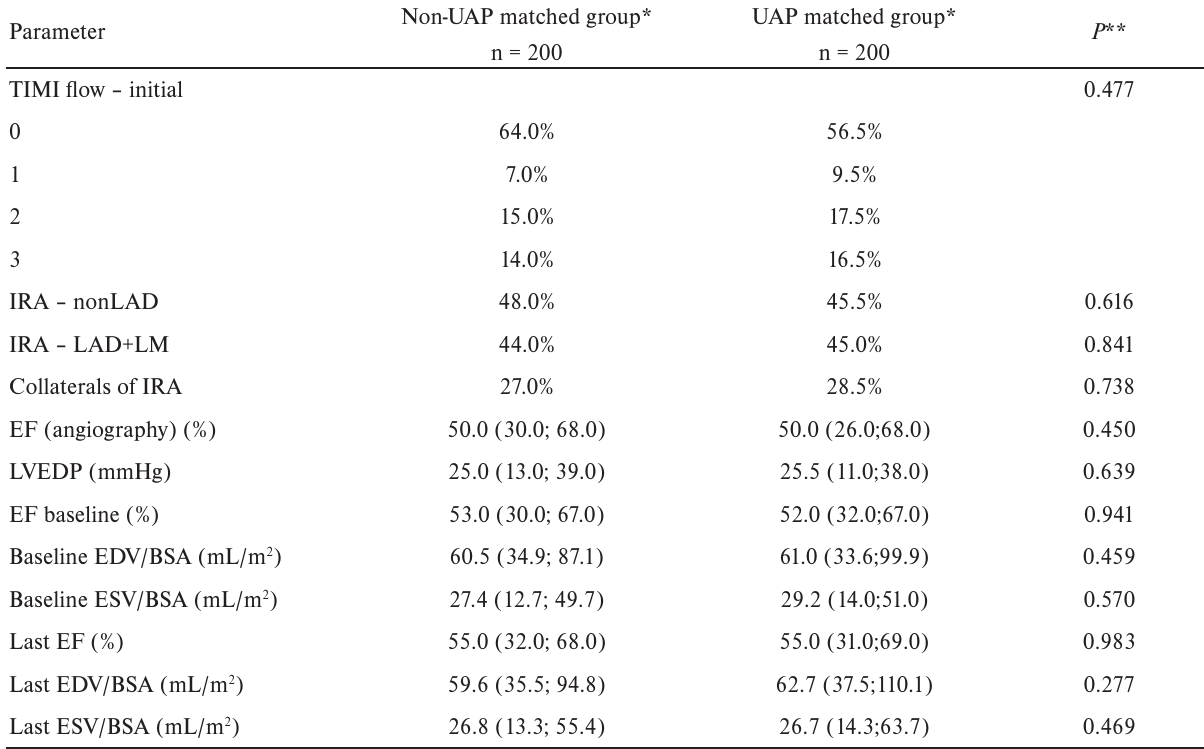
*Continuous parameters are described using median and 5-95 th percentile; categorical parameters are described by frequency and percentage of categories, **Statistical significance evaluated by Mann-Whitney U test for continuous variables and Fisher exact test for categorical